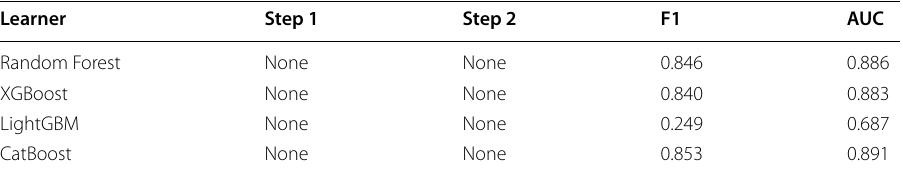
Table 2 Performance scores for baseline